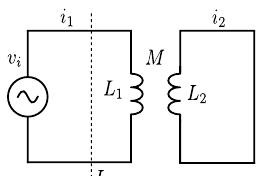
Figure A1. Equivalent circuit coil-vehicle undercarriage.